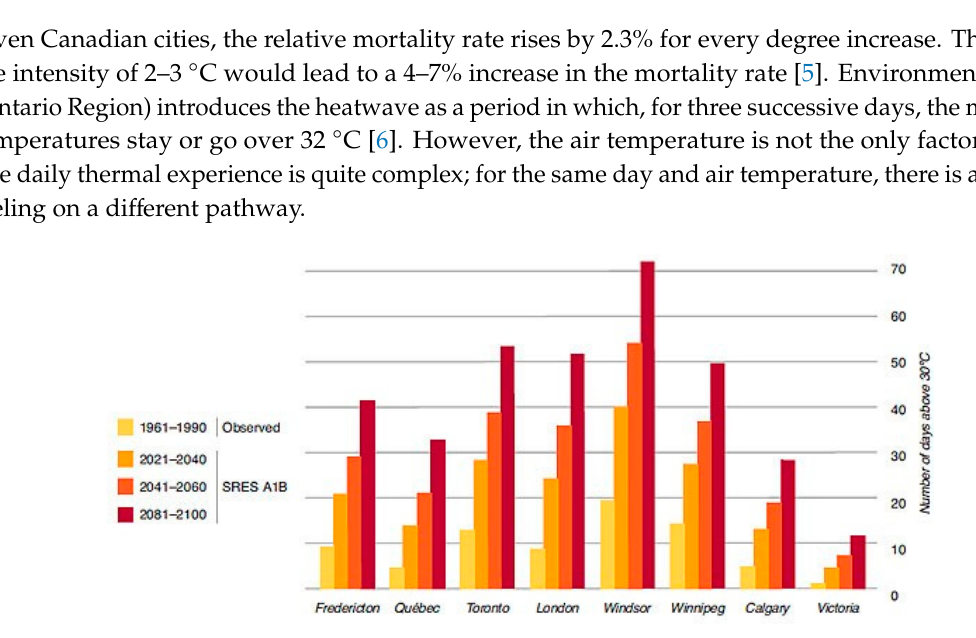
Figure 1. Current and projected number of days exceeding 30 °C for Canadian cities [3] based on the observed temperature data between 1961 and 1990.